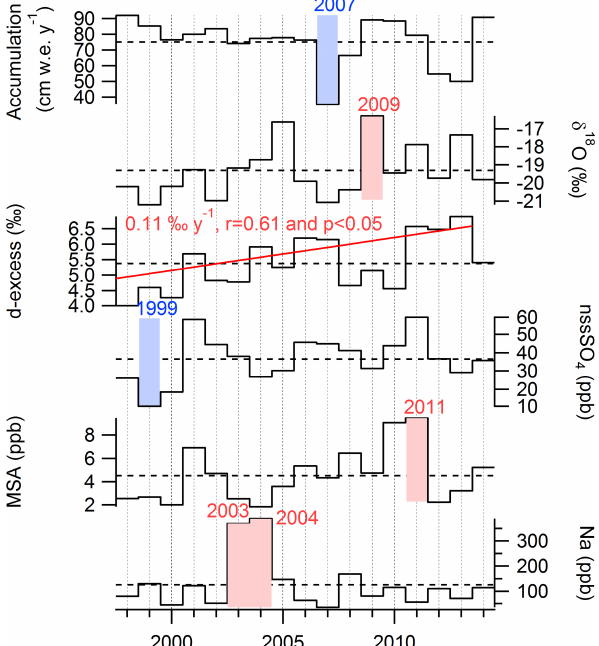
Figure 7. Dated TA192A ice core annually averaged records over the period 1998–2014: accumulation, cmw.e.yr − 1 ; concentrations of Na + (ppb), nssSO 4 (ppb), MSA (ppb), δ 18 O (‰), and d -excess (‰). Horizontal dashed lines correspond to 1998–2014 average val- ues. Remarkable years (i.e. associated with values deviating by at least 2 standard deviations from the climatological mean value) are highlighted with red shading (positive anomalies) or blue shading (negative anomalies). The same figure with standard deviations is available in the Supplement (Fig.